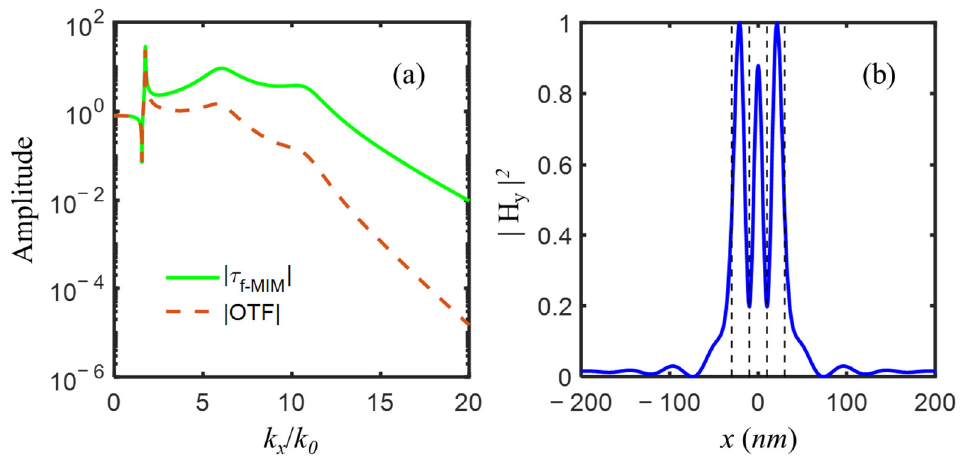
(cid:12) (cid:12) (cid:12) (cid:12) OTF and transmission coefficient f MIM (cid:12) τ f − MIM (cid:12)